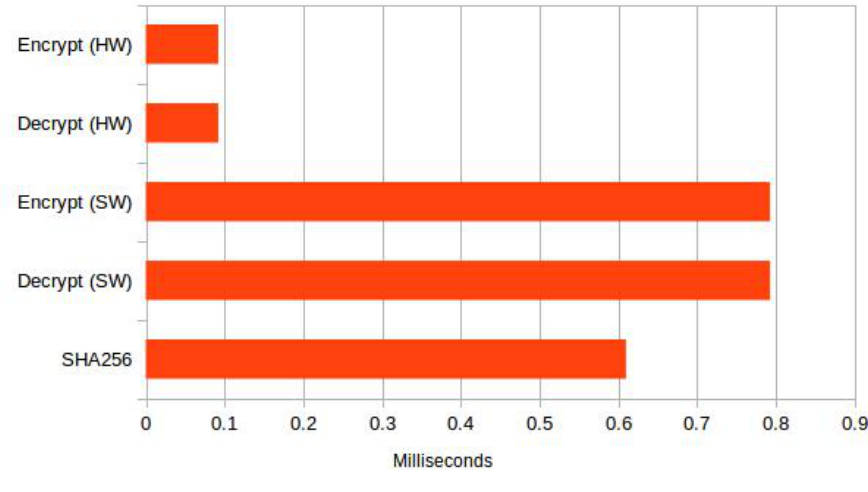
Figure 10. Seal/unseal external sensor